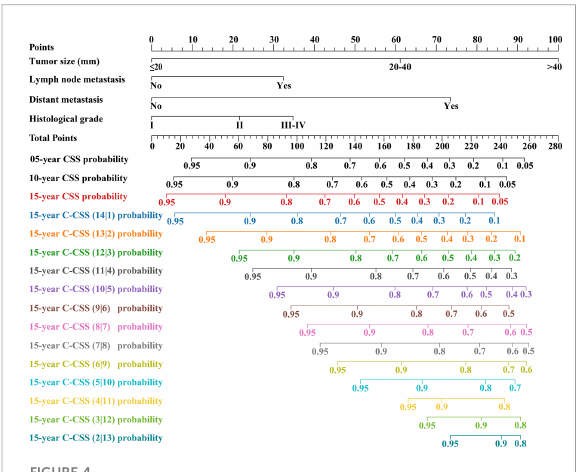
FIGURE 4 Conditional survival nomogram (CS-nomogram) for predicting 5-, 10- and 15-year cancer-speci fi c survival (CSS) and 15-year conditional CSS (C-CSS) for cervical